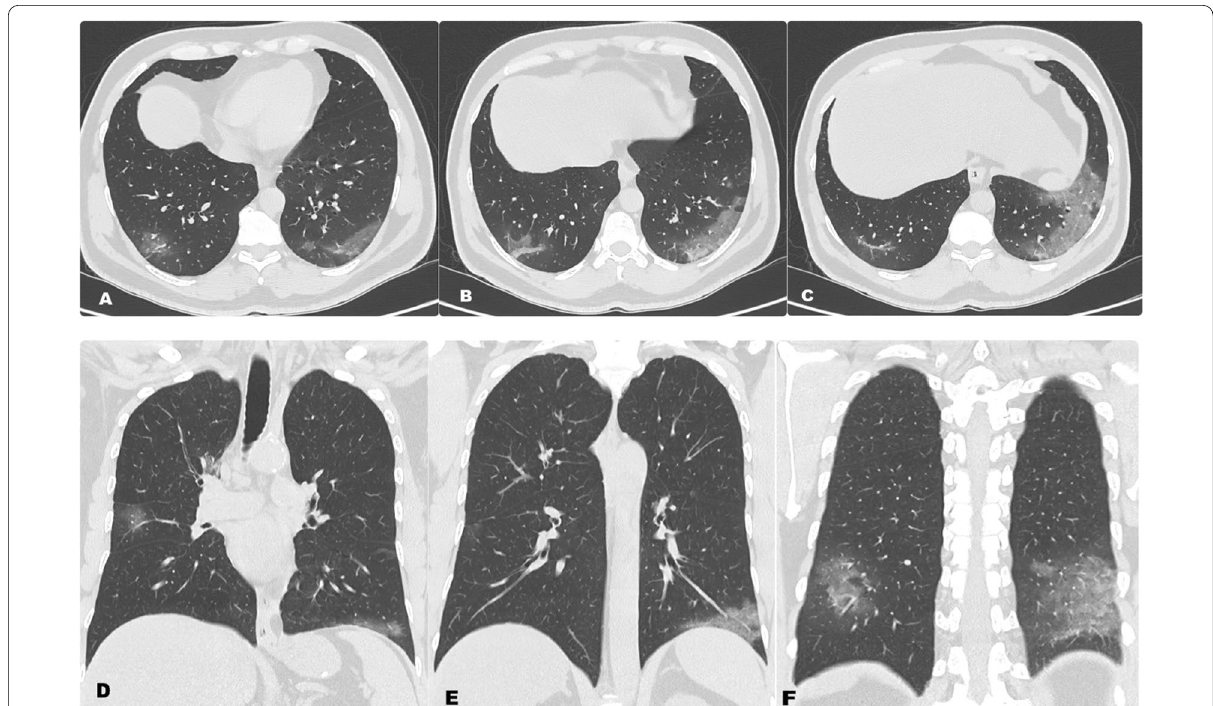
Fig. 1 A – C Axial and D – F reformatted coronal non‑contrast CT chest of a 56‑year‑old male patient with positive RT‑PCR for Covid‑19, show bilateral scattered ground‑glass opacities with a primarily peripheral distribution. CT severity score is 7 points which corresponds to mild